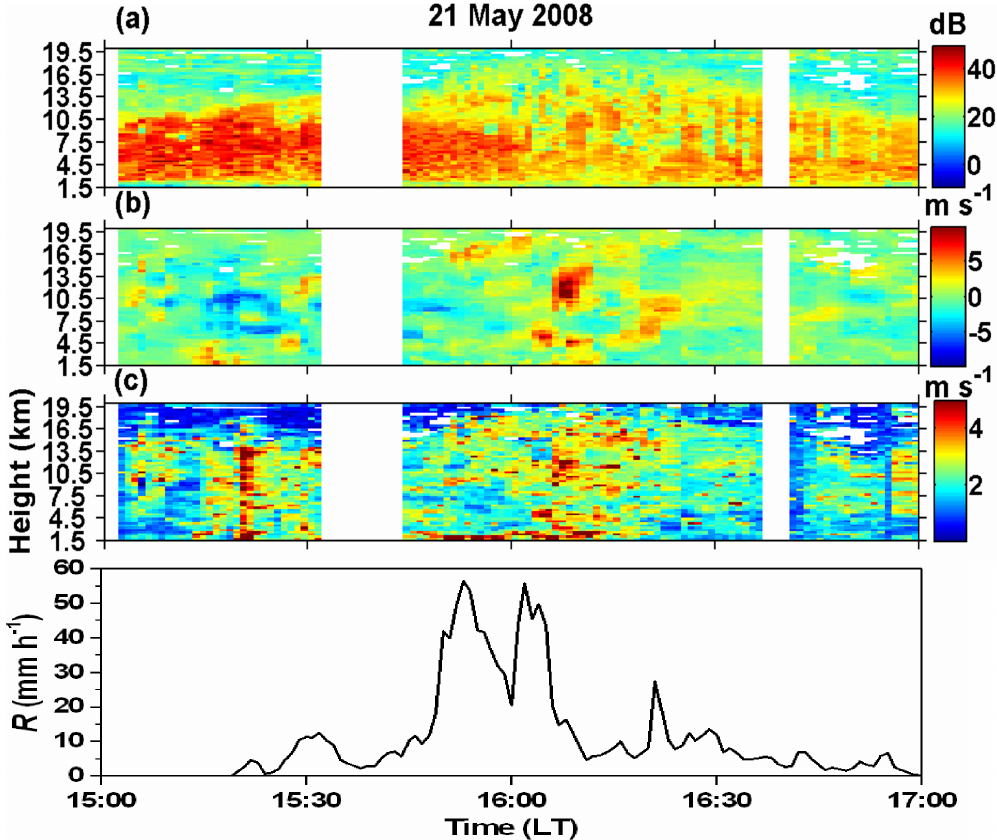
Fig. 1. Time-height contours of (a) range corrected SNR, (b) the vertical air velocity and (c) spectral width observed with the IMSTR on 21 May 2008. The data gaps are shown as white patches. The bottom panel shows temporal variation of surface rainfall derived from ORG.